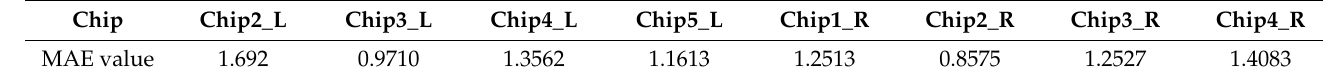
Table 3. Discrete point fitting MAE evaluation (unit: